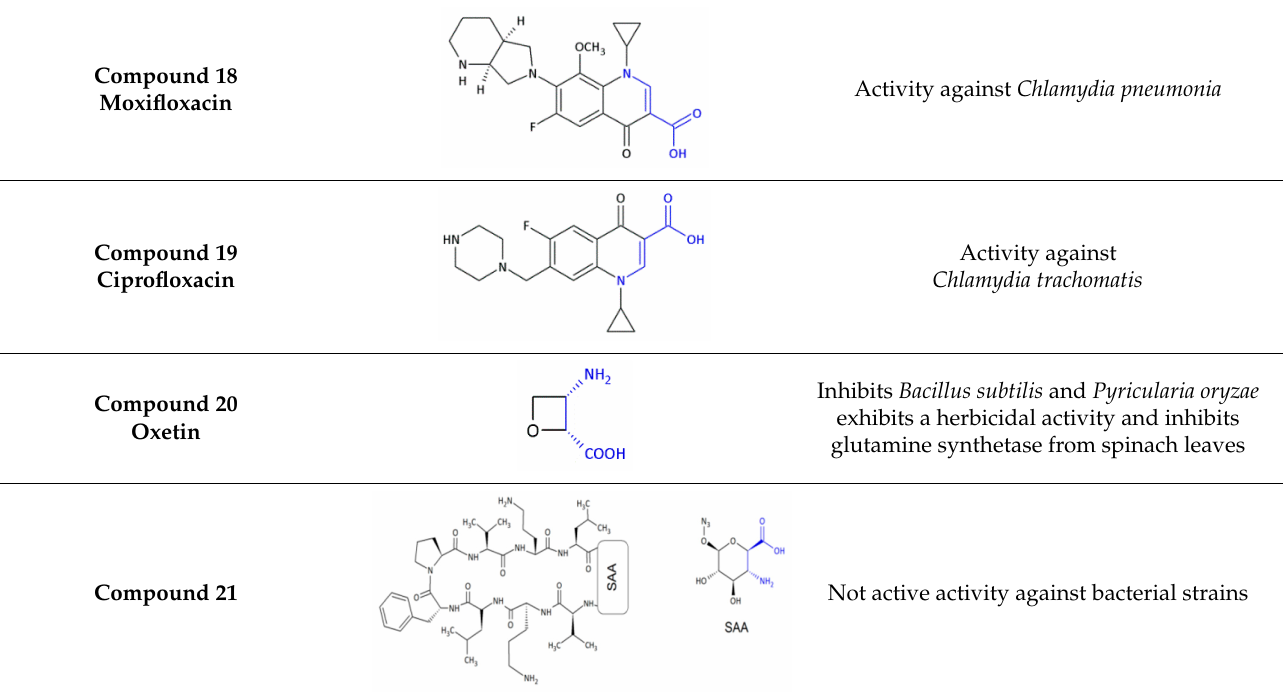
Table 4. Schematic presentation of β -, β 2 -, β 3 - and β 2,3 -amino acid heterocyclic derivatives with antibacterial